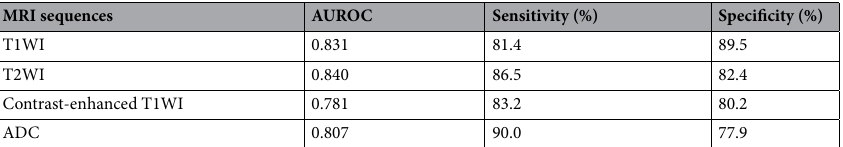
Table 2. Diagnostic performance of RFA to discern occult palatine tonsil SCC from normal palatine tonsils according to the MRI sequences. ADC apparent diffusion coefficient; AUROC area under the receiver operating curve; T1WI T1-weighted image; T2WI T2-weighted image.